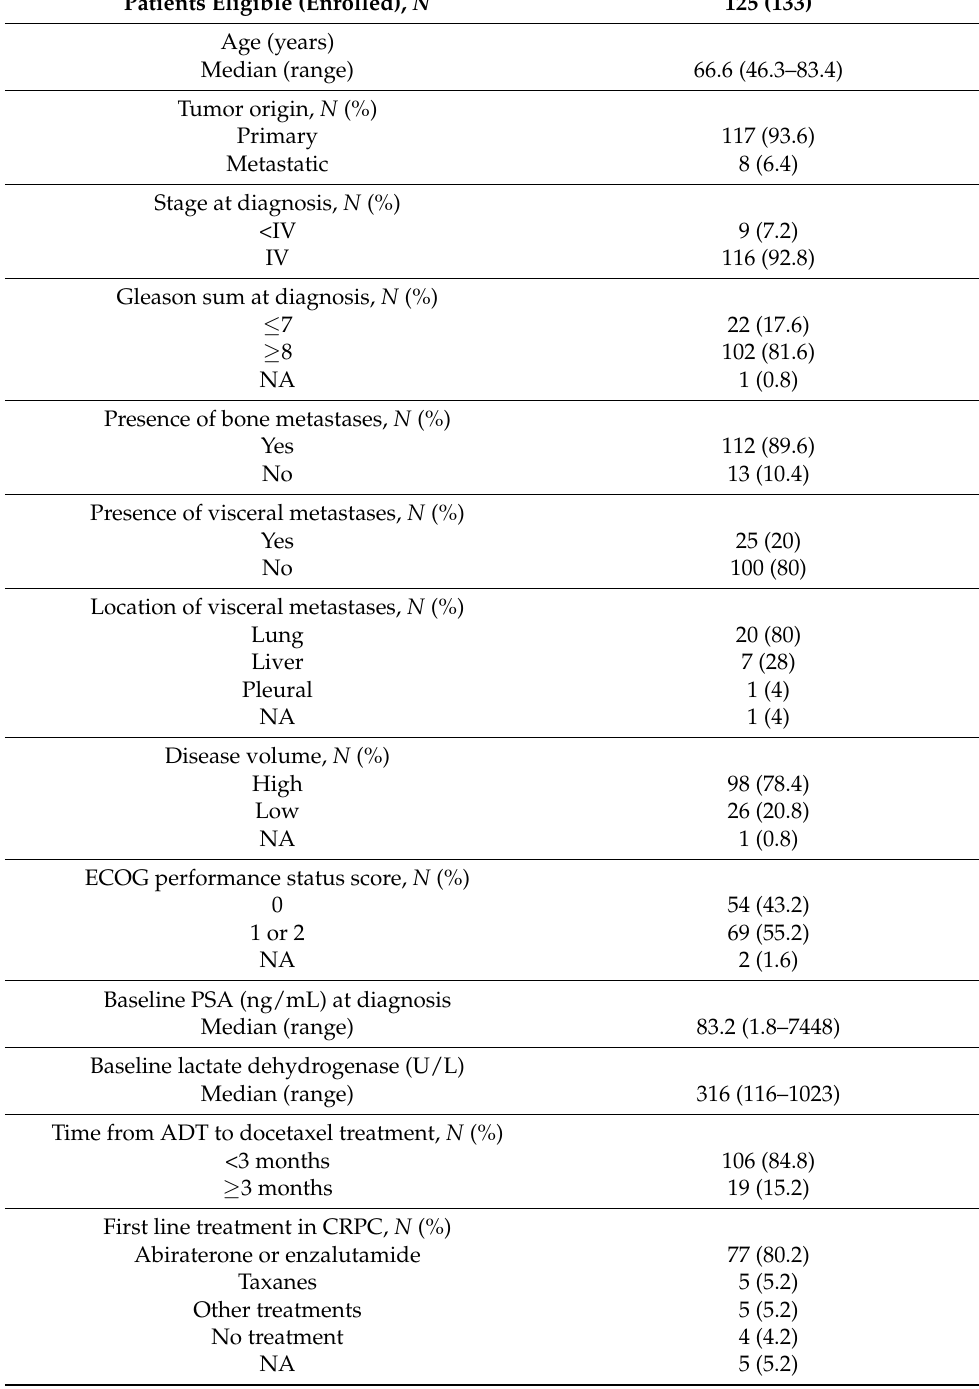
Table 1. Patients’ characteristics. N : number of cases; ADT: androgen deprivation therapy; ECOG: Eastern Cooperative Oncology Group; PSA: prostate-specific antigen; CRPC: castration-resistant prostate cancer; NA: not